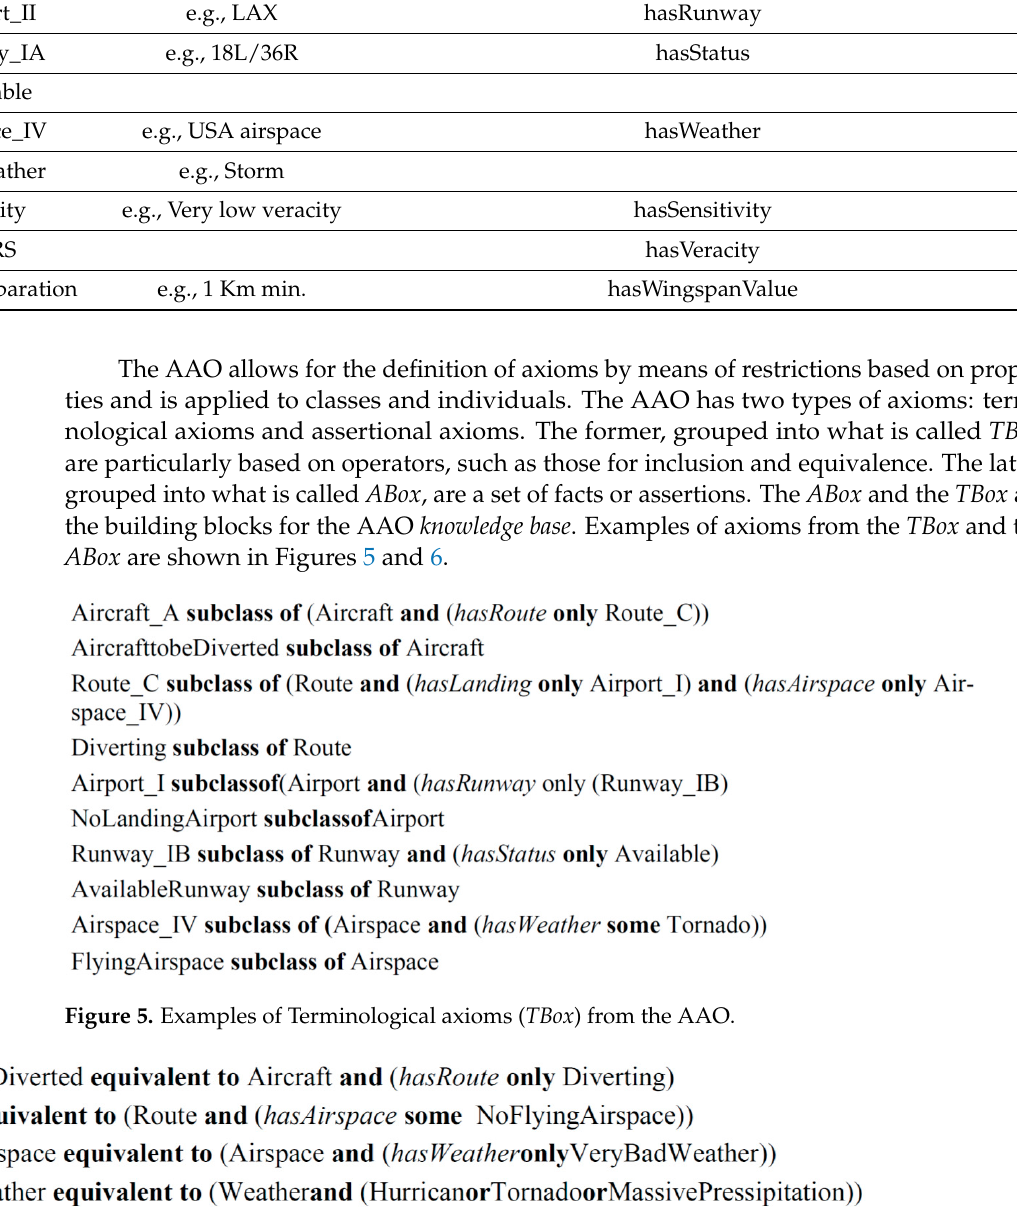
Figure 6. Examples of Assertional axioms ( ABox ) from the AAO.